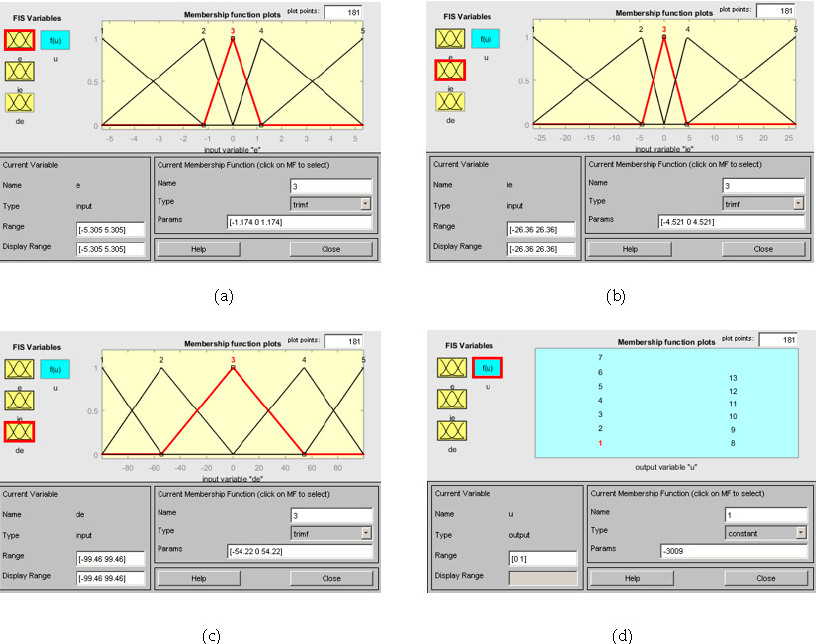
(cid:82) . e ( t ) ; ( c ) e ( t ) ; and ( d ) u ( t ) in Matlab.